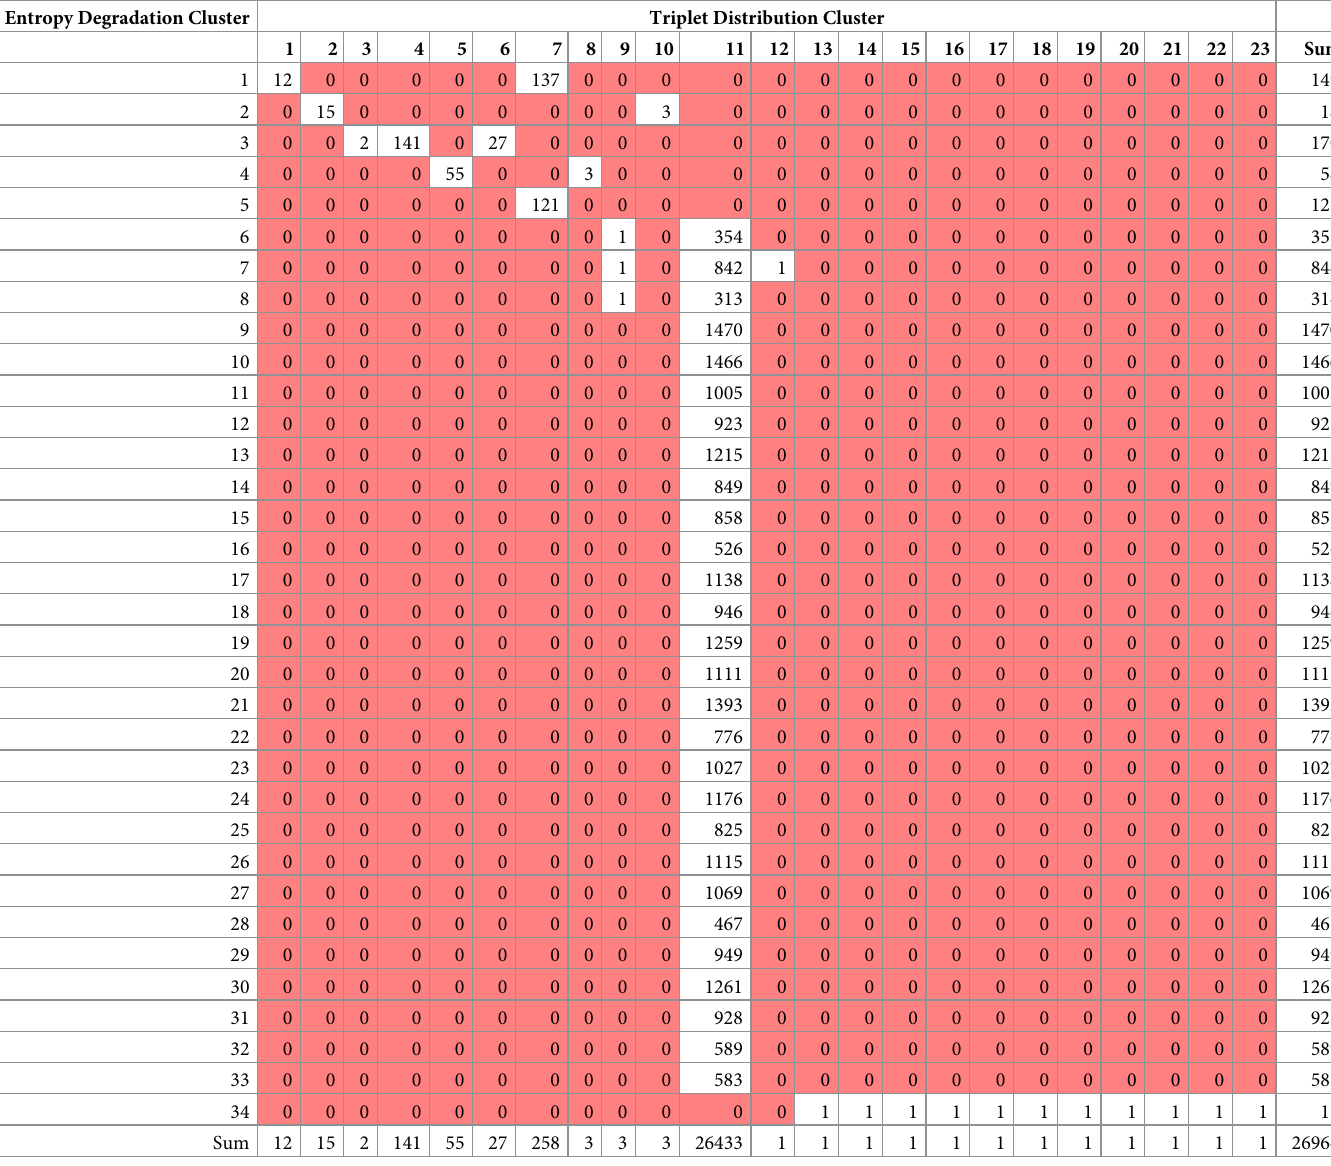
Table 1. Cross-tabulation of the 34 degradation clusters (rows) and the 23 triplet distribution clusters (columns). Cells containing zeros are shaded in red. Entropy Degradation